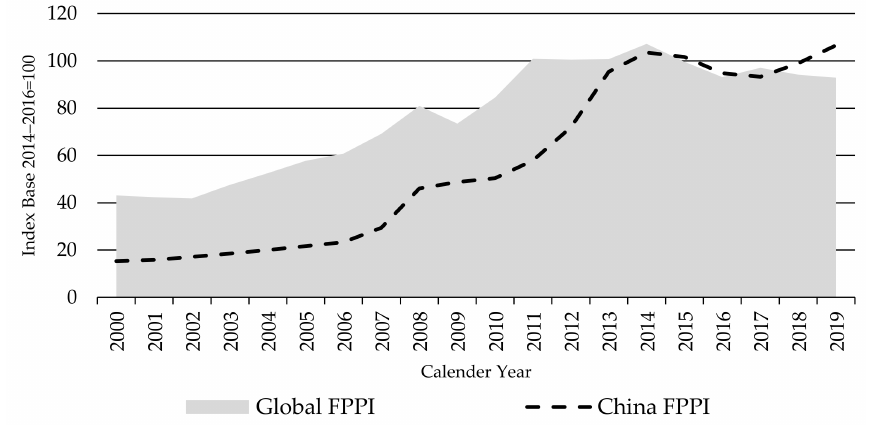
Figure 6. The Global and China Finished Cattle Producer Price Indices FPPIs, source: own